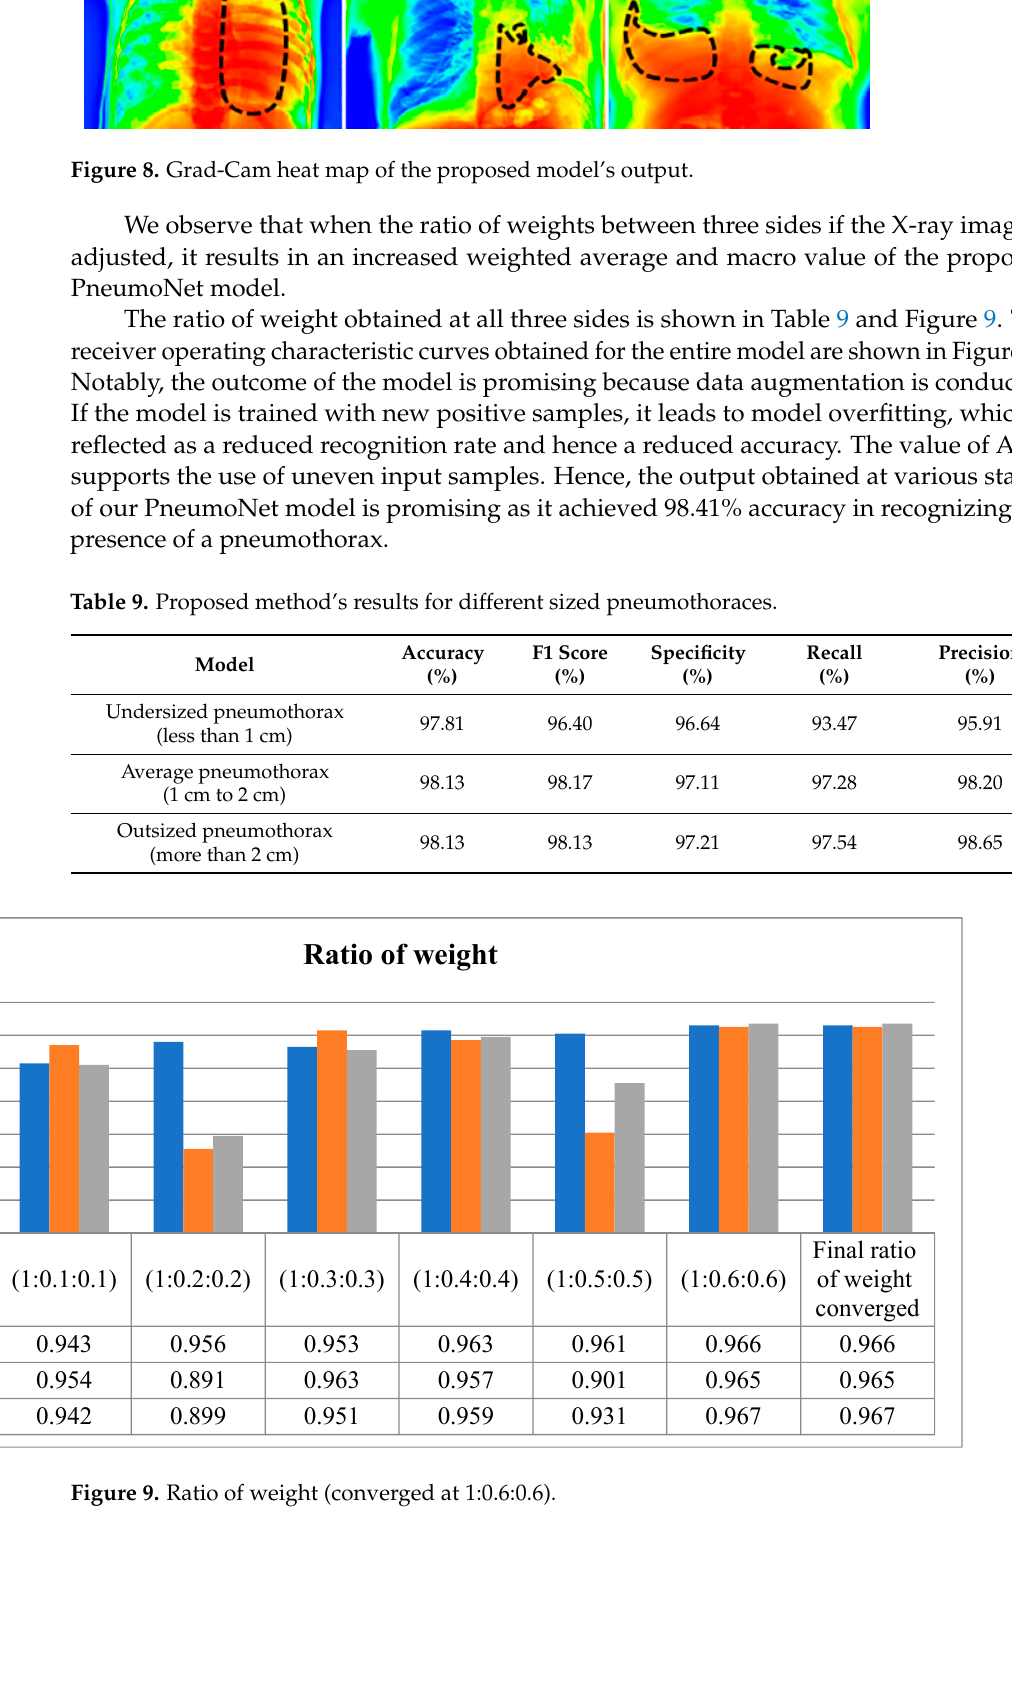
Figure 10. Receiver operating curves (ROC).